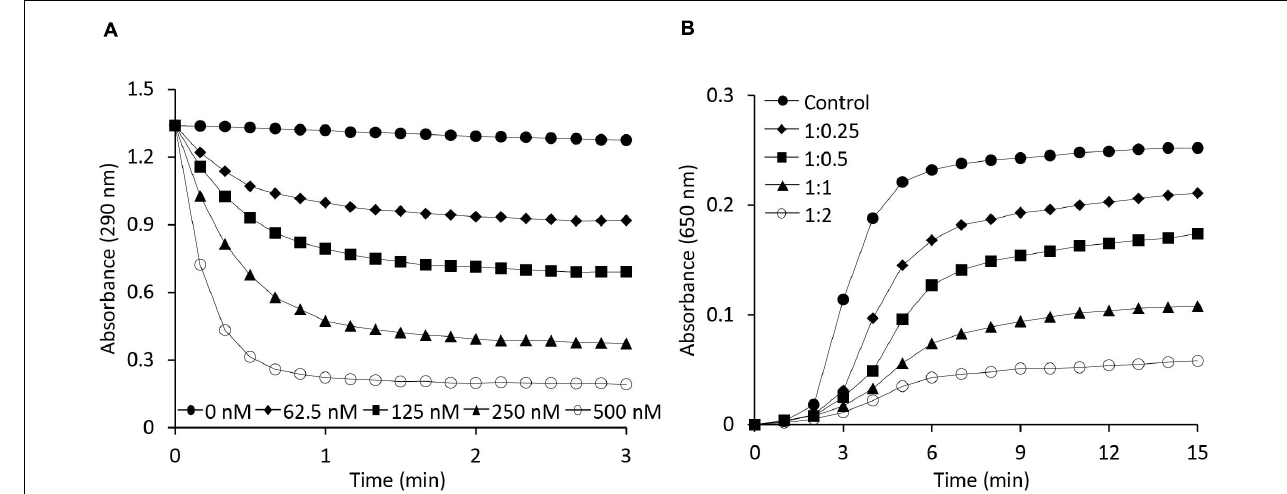
FIGURE 2 | Functional analysis of AtAPX1 protein as ascorbate peroxidase and molecular chaperone. (A) The APX activity was monitored by measuring the reduction in absorbance at 290 nm using ( (cid:117) ) 62.5 nM, ( (cid:110) ) 125 nM, ( (cid:115) ) 250 nM, ( measured at 650 nm using malate dehydrogenase (MDH) as a substrate. Thermal aggregation of 1 µ M MDH was examined at 43 ◦ C for 15 min in the presence of purified AtAPX1 protein in molar ratios of MDH:AtAPX1, ( (cid:117) ) 1:0.25, ( (cid:110) ) 1:0.5, ( (cid:115) ) 1:1, and ( absence of AtAPX1.